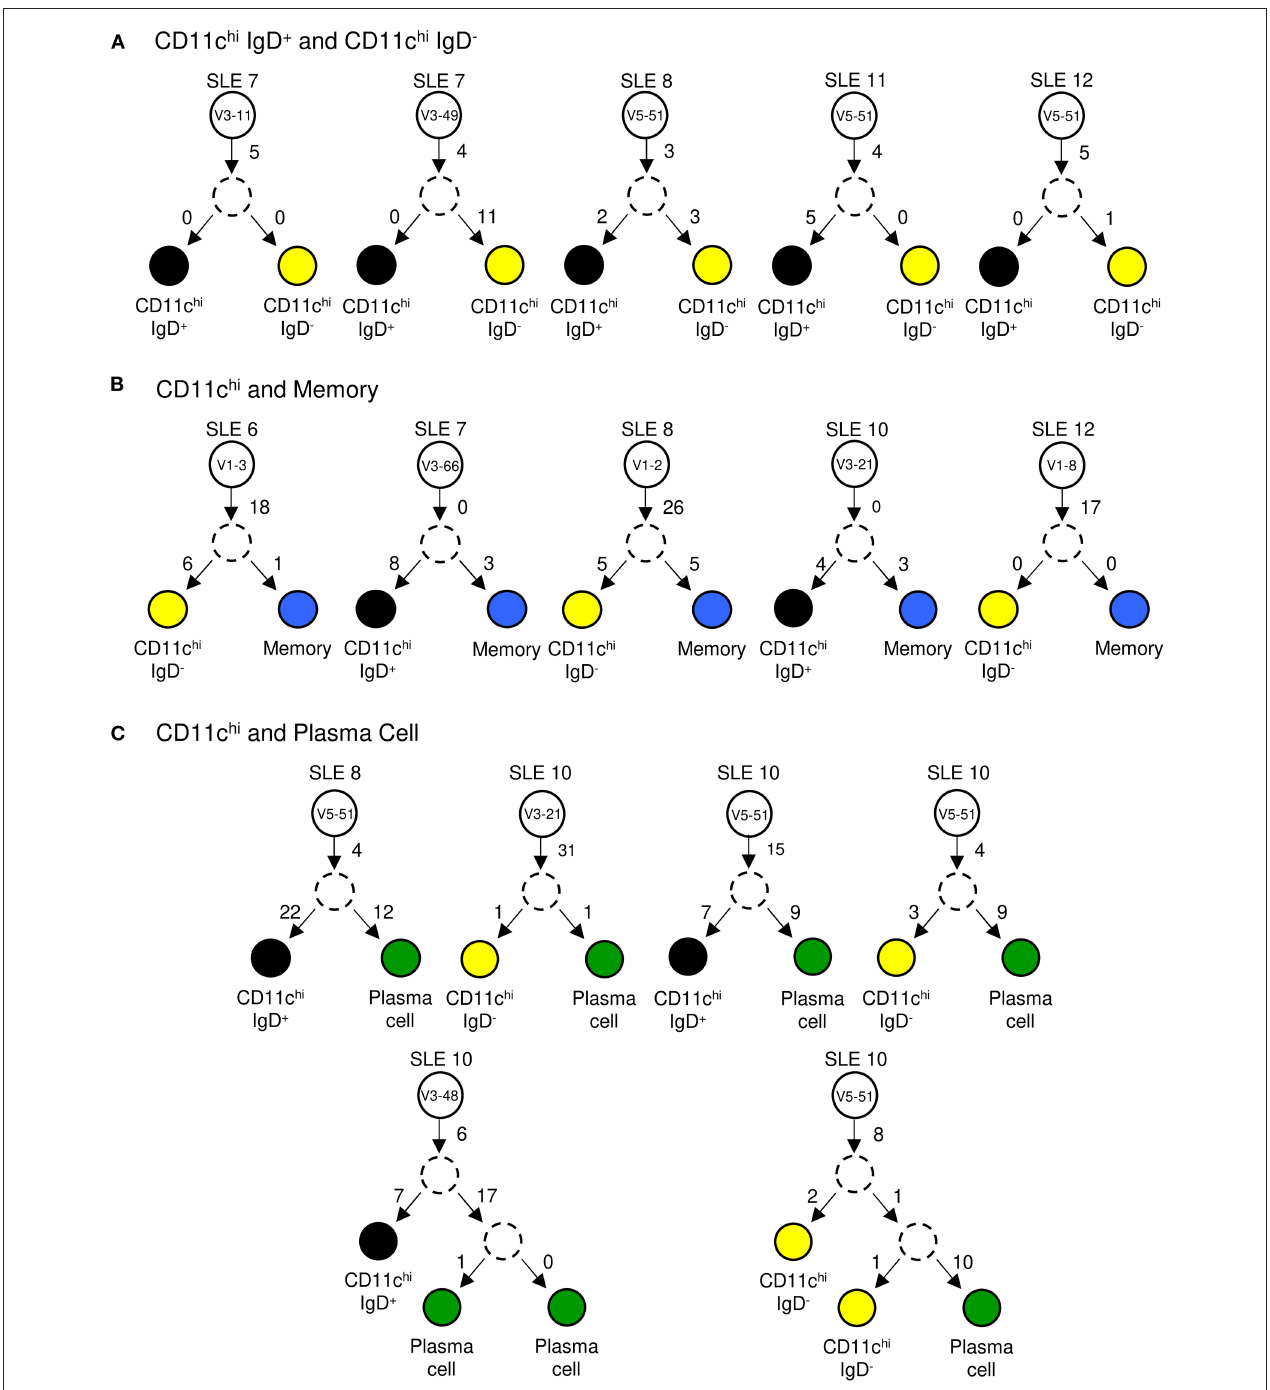
FIGURE 8 | Clonal tree analysis. IgH V-genes with identical CDR3 nucleotide sequences were compared between two independently sorted populations from a single patient. Examples of shared sequences between: (A) CD11c hi IgD + (black circle) and CD11c hi IgD − (yellow circle) clones, (B) CD11c hi IgD + or IgD − and memory (blue circle) B cell clones, and (C) CD11c hi IgD + or IgD − and plasma cell (green circle) clones. White circles represent the naïve precursor labeled with its V-gene identity. Dashed circles represent a hypothetical intermediate cell which contained shared mutations before diverging. Numbers on arrows represent the number of mutations between